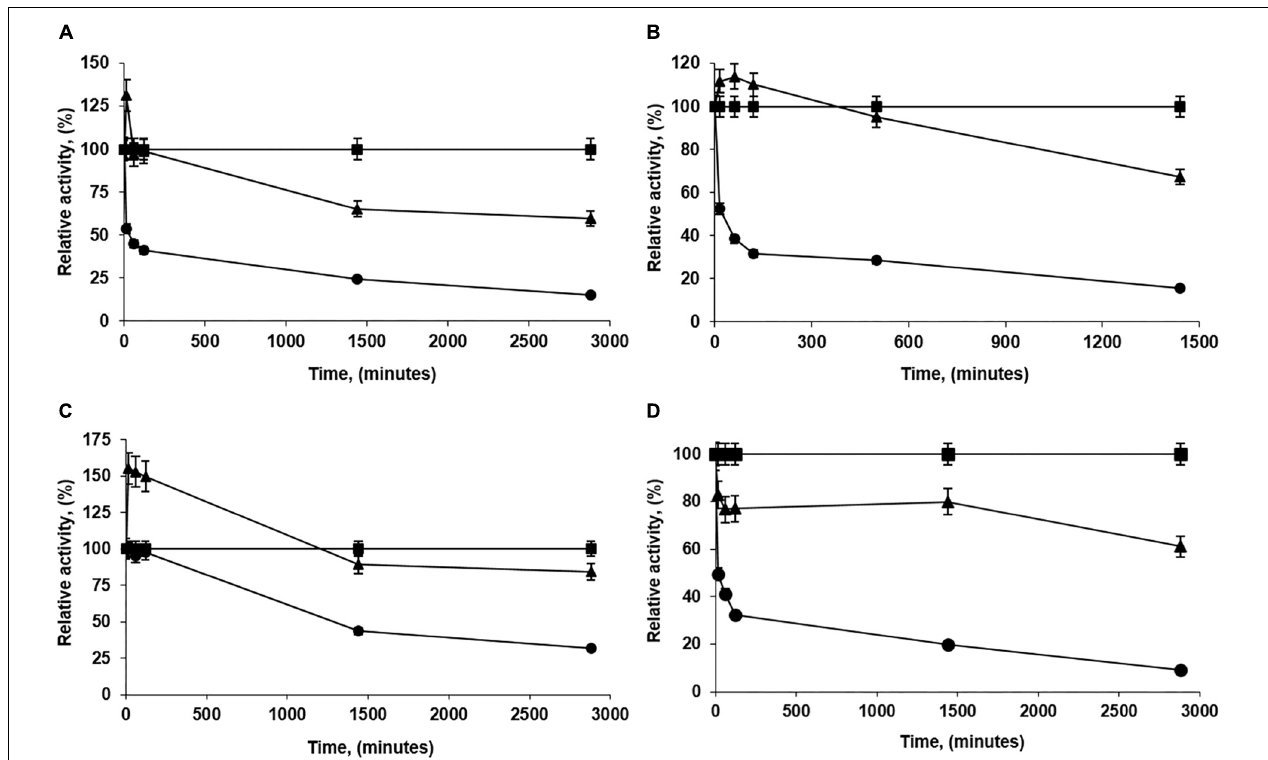
FIGURE 3 | Immobilization courses of high loaded PFL preparations (60 mg/g). Immobilization conditions: (A) 5 mM of sodium acetate buffer at pH 5.0; (B) 100 mM of buffer sodium phosphate at pH 7.0; (C) 5 mM of Tris buffer with 30% of glycerol at pH 7.0 and (D) 5 mM of sodium bicarbonate buffer with 250 mM NaCl at pH 9.0. Other specifications are described in section “Methods.” Solid squares: reference; solid triangles: suspension and solid circles: